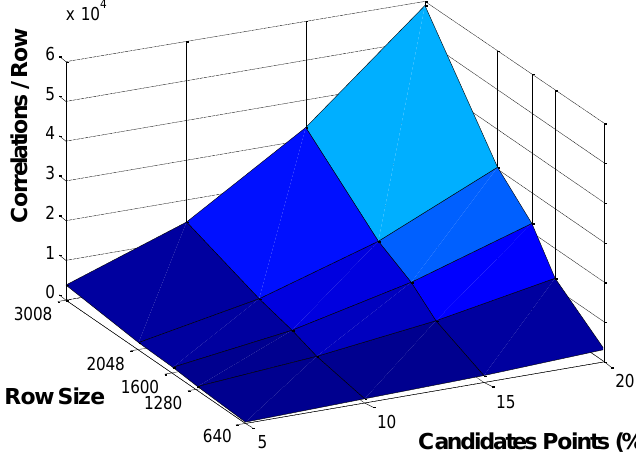
Figure 14. Example of estimated number of correlations for each